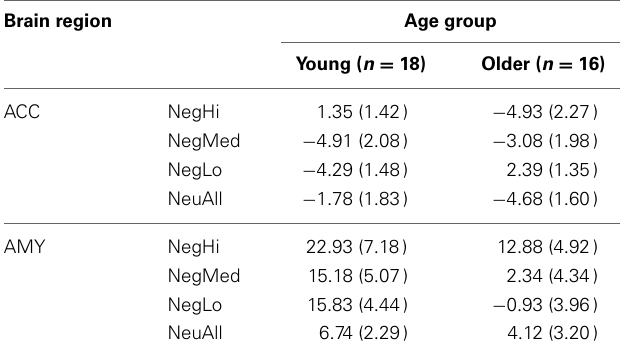
Table 5 | Mean parameter estimates for peak voxel activity in anterior cingulate cortex (ACC) and amygdala (AMY) for young and older groups.